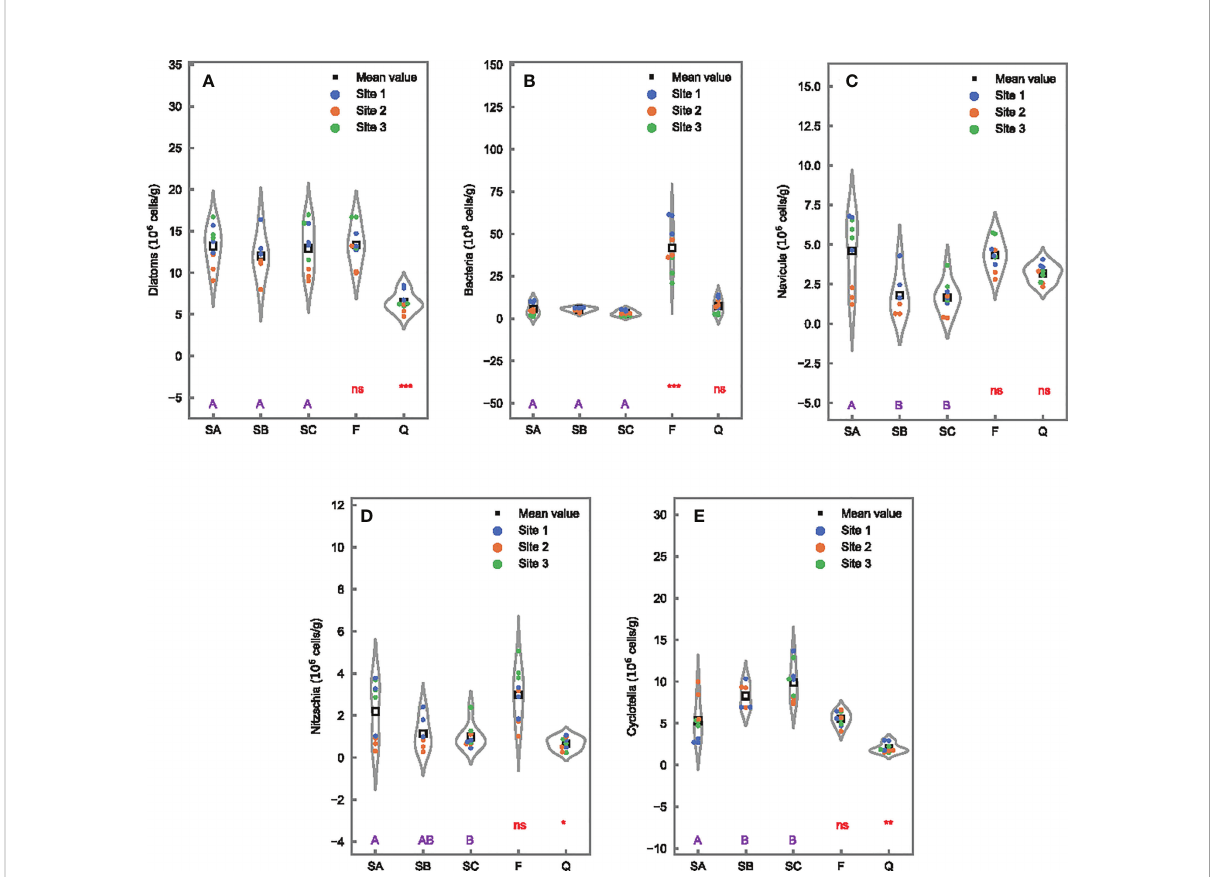
FIGURE 3 Microbial composition in 0- to 1-cm surface sediments and differences of microbial abundance among tidal levels in Futian (SA, SB, and SC), between sampling times (SA vs. F), and between Futian and Qi ’ ao wetlands (SA vs. Q). Different letter shows signi fi cant differences among tidal levels at p < 0.05 according to one-way ANOVA, while *, **, and *** indicate signi fi cant differences between times, as well as between mangrove wetlands, at p < 0.05, 0.01, and 0.001, respectively, ns indicates not signi fi cant difference, according to Student ’ s t -test: (A) diatoms; (B) bacteria; (C) Navicula ; (D) Cyclotella ; and (E) Nitzschia